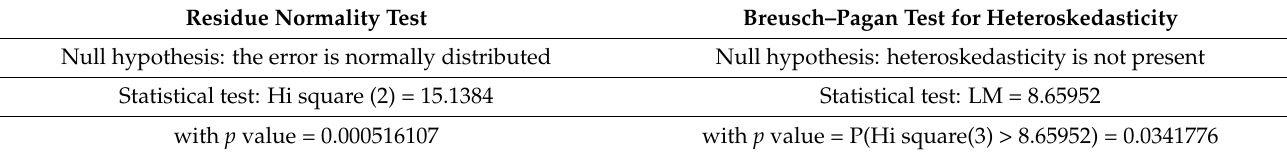
Table 5. Statistical tests to validate the Asian volatility matrix